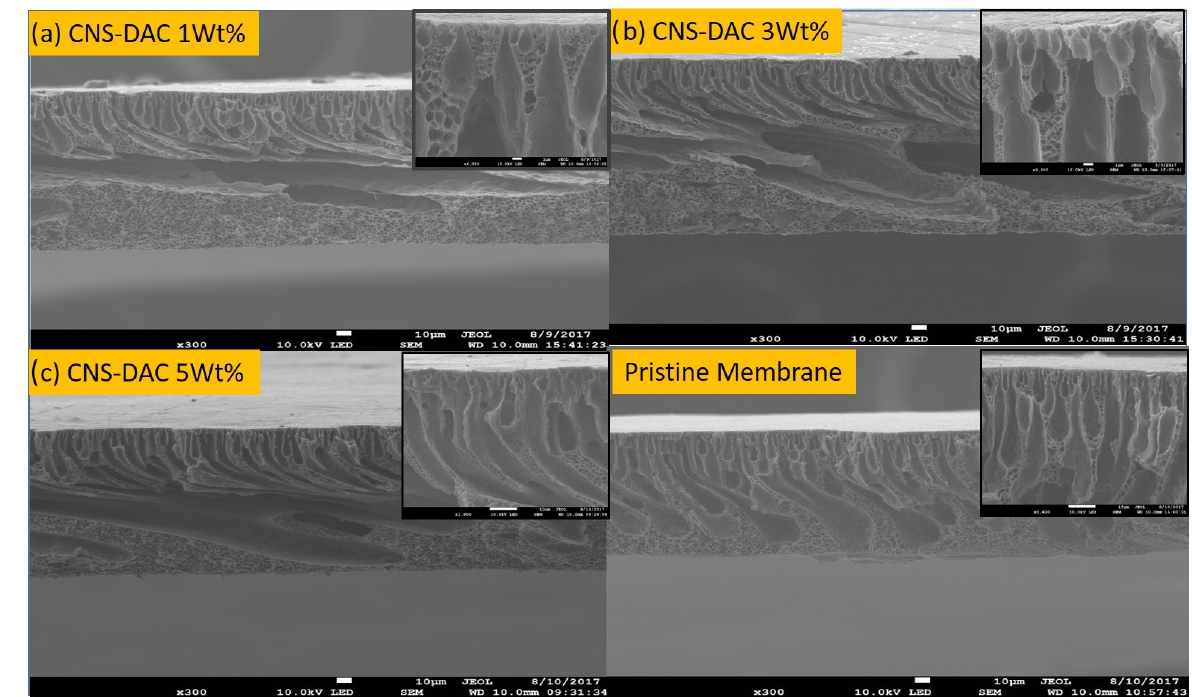
Figure 5. SEM micrographs of the composite membranes’ cross-sectional area.